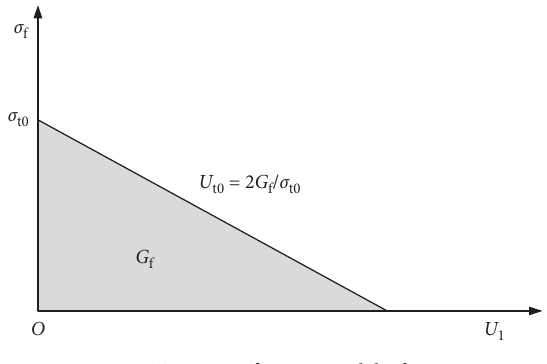
Figure 3: Tension softening model of concrete.